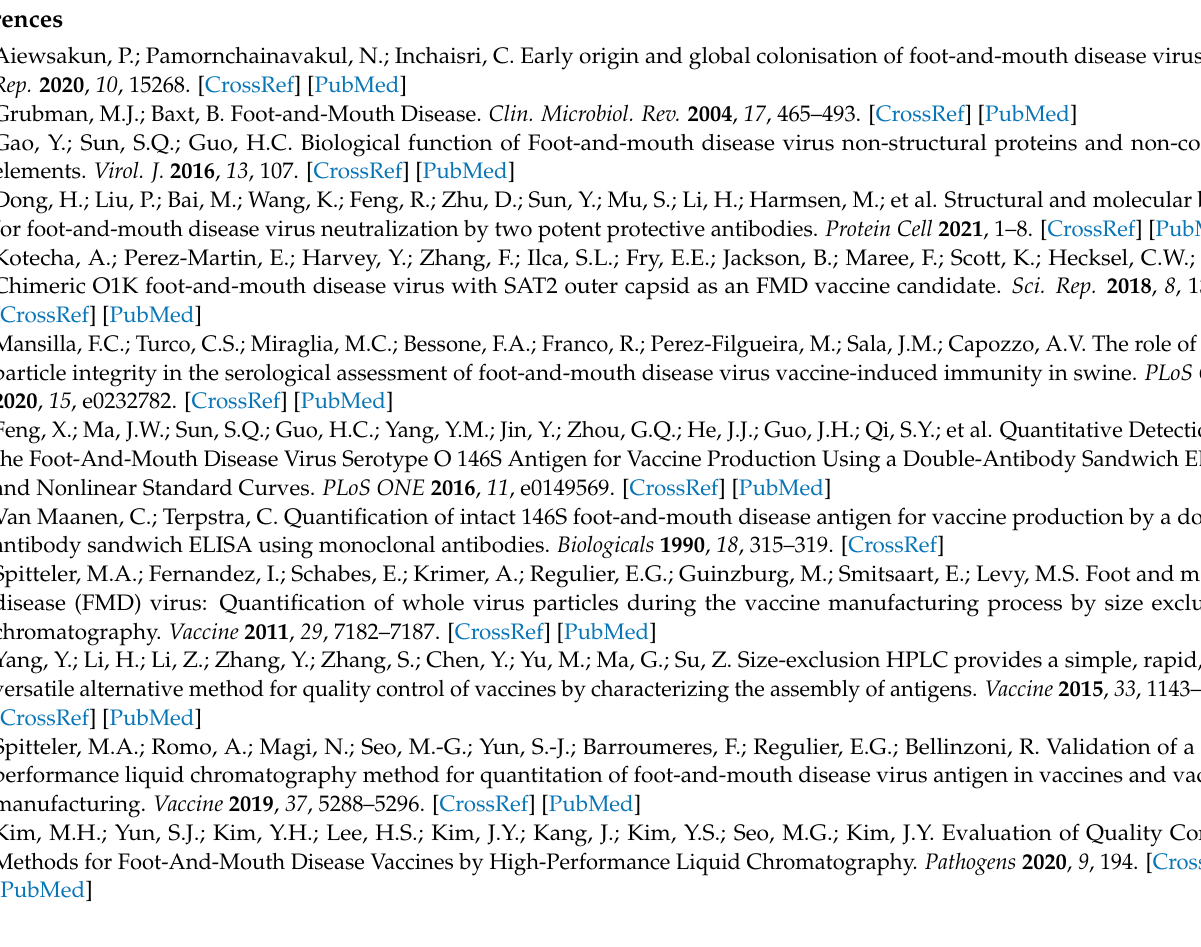
10.3390/vaccines9111361/s1, Figure S1: Purity of 146S antigen peak fractions collected by SDG fractionation from the 10 × concentrates for crude virus infection supernatant (CVIS) of FMDV O SKR/Boeun/2017, Figure S2: Purity of 146S antigen peak fractions collected by SDG fractionation from the 10 × concentrates for PEG precipitate (PEG-P) of FMDV O SKR/Boeun/2017, Figure S3: Representative original chromatograms drawn by SDG fractionation of CVIS (1 × ) with or without spiked 146S antigens, Figure S4: Representative original chromatograms drawn by SE-HPLC of CVIS (1 × ) with or without spiked 146S antigens, Figure S5: Representative original chromatograms drawn by SDG fractionation of PEG-P (1 × ) with or without spiked 146S antigens, Figure S6: Representative original chromatograms drawn by SE-HPLC of PEG-P (1 × ) with or without spiked 146S